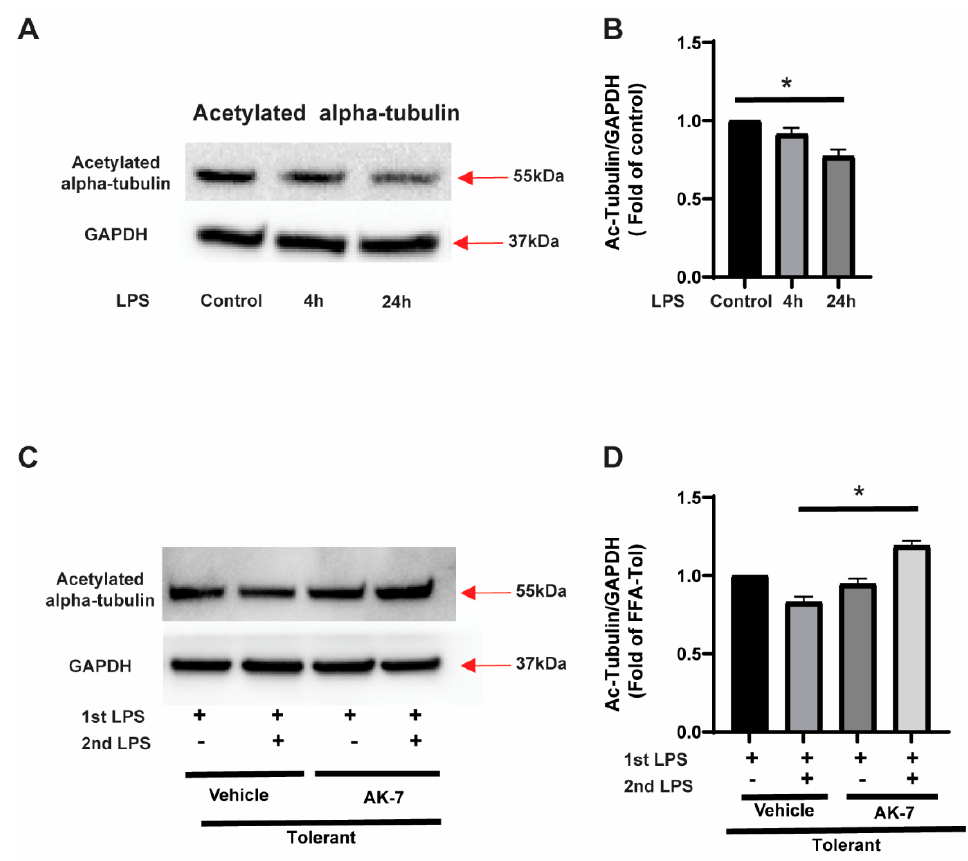
Figure 6. Acetylated alpha-tubulin expression in sensitive and tolerant macrophages. Stearic acid (free fatty acid: FFA)-exposed sensitive and tolerant RAW264.7 cell macrophages (RAW) were stimulated with or without LPS for 4 h or 24 h. Loading control: GAPDH. ( A ) Acetylated alpha-tubulin protein expression was detected in the cytosolic extract by Western blot. ( B ) Western blot image quantification using image-J software (n = 5 blots; * p < 0.05). ( C ) FFA-exposed tolerant RAW cells were treated with SIRT2 inhibitor AK-7 (25 µM) or vehicle (DMSO; equal volume) and incubated further for 20 h and stimulated with or without LPS as indicated. Acetylated alpha-tubulin protein expression was detected in the cytosolic extract by Western blot. ( D ) Western blot image quantification of acetylated alpha-tubulin using image-J software (n = 5 blots; * p <